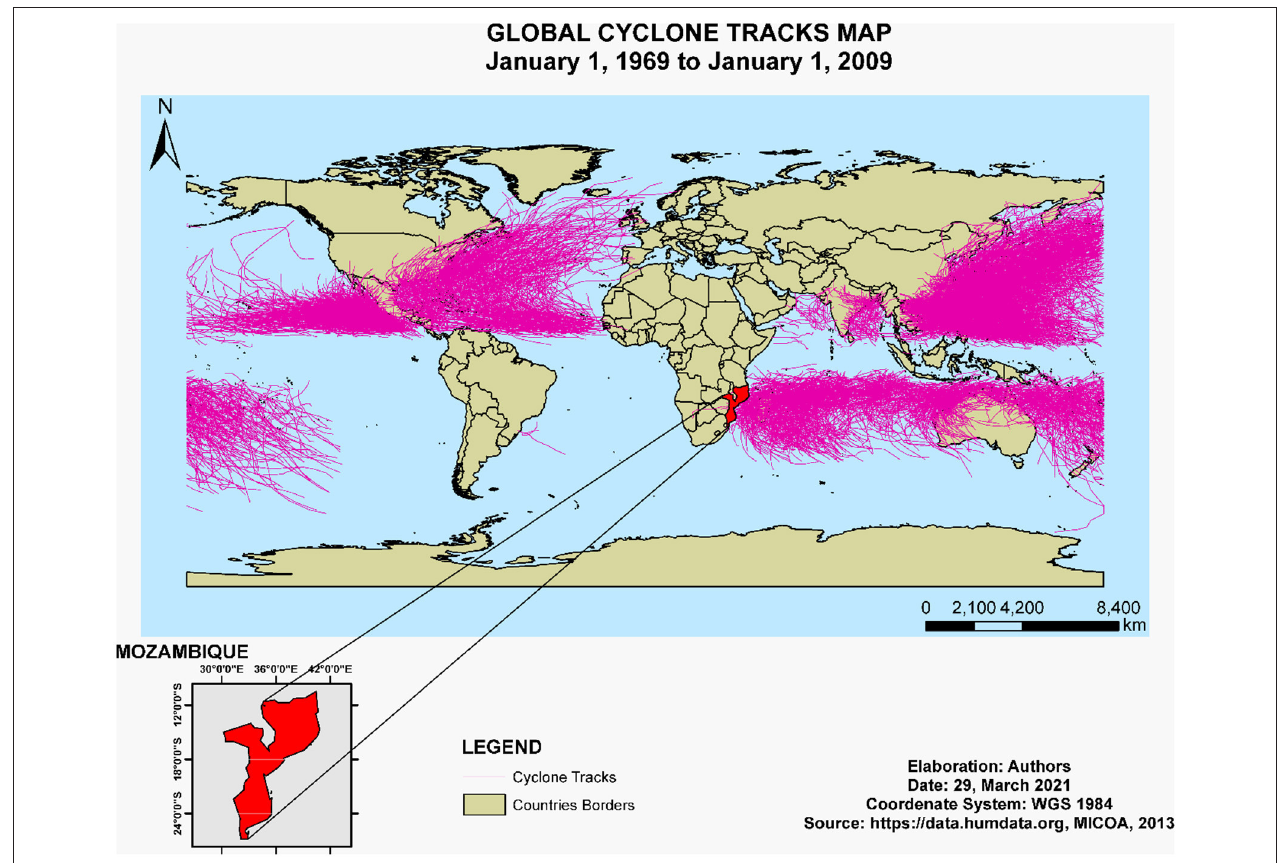
FIGURE 3 | Global cyclone tracks map. Source: Authors.